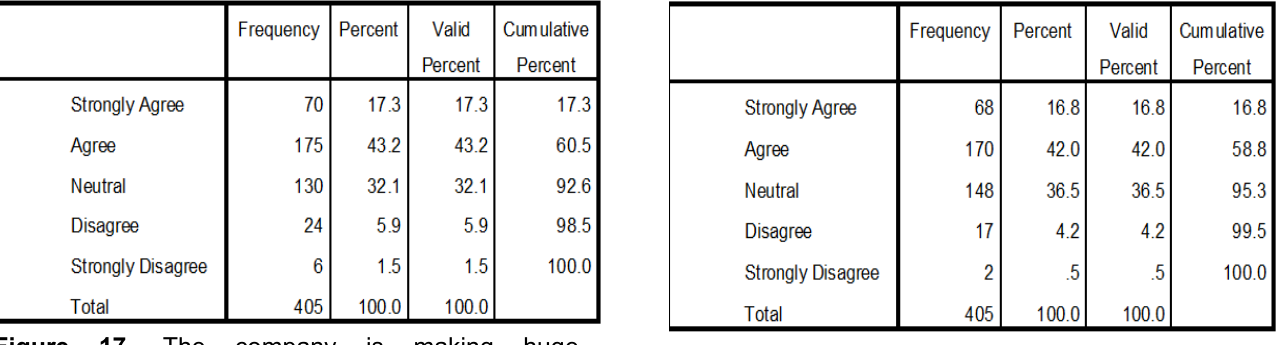
Figure 19. the Company’s growing activity in India and abroad implied higher